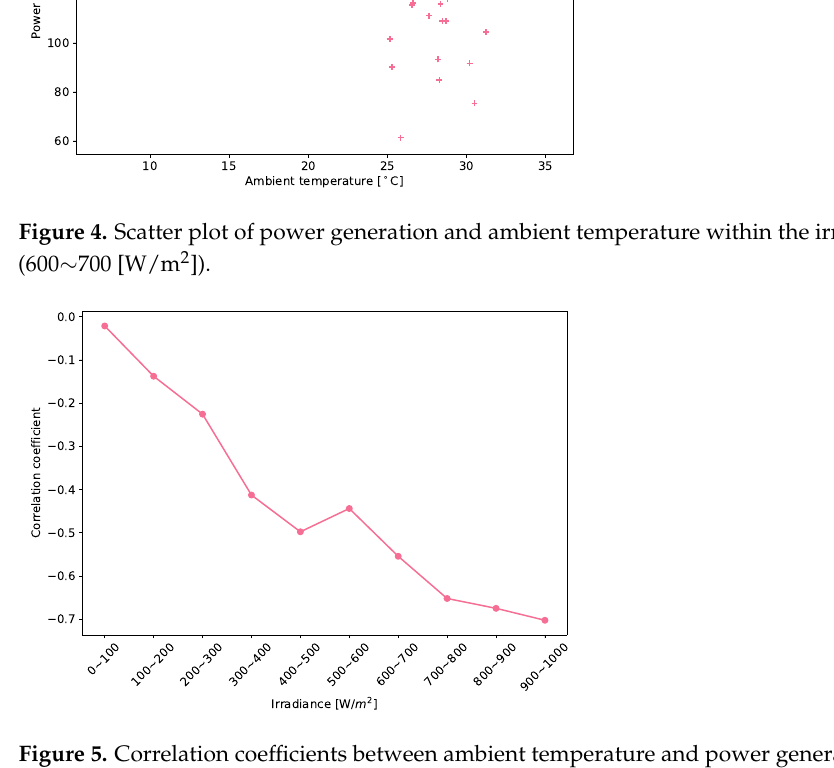
Figure 5. Correlation coefficients between ambient temperature and power generation in different irradiance